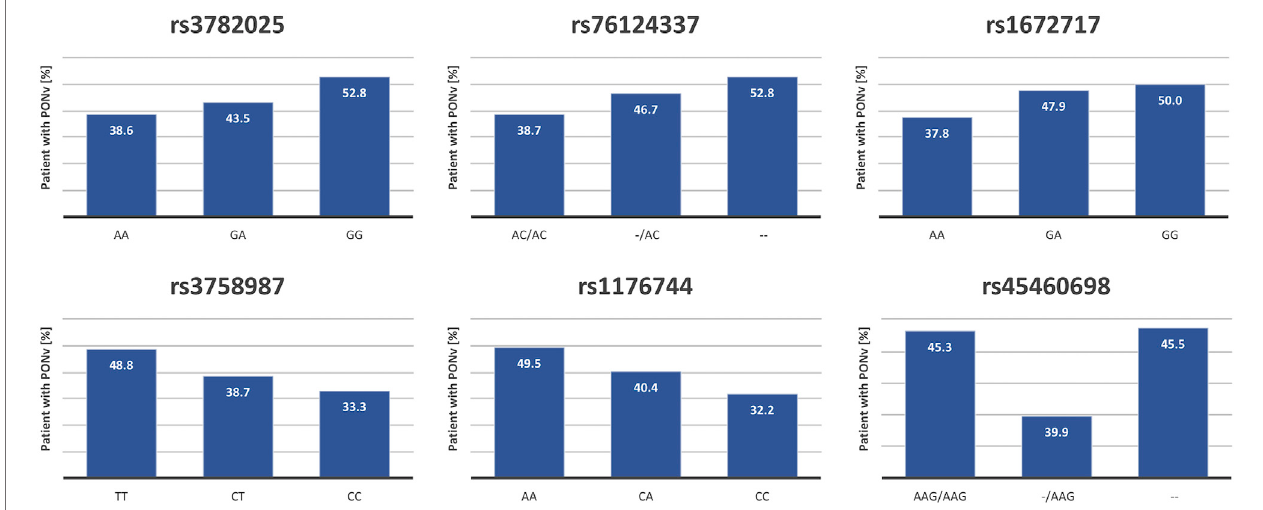
FIGURE 1 | Correlation between HTR 3B polymorphisms and PONV occurrence. Five of the six HTR 3B polymorphisms tested in the screen were signi fi cantly correlated with the risk of PONV occurrence. The fi gure shows, for each of those SNPs, the proportion (%) of patients suffering from PONV in each genotypic category. The homozygous genotype corresponding to the major allele is always depicted on the left.